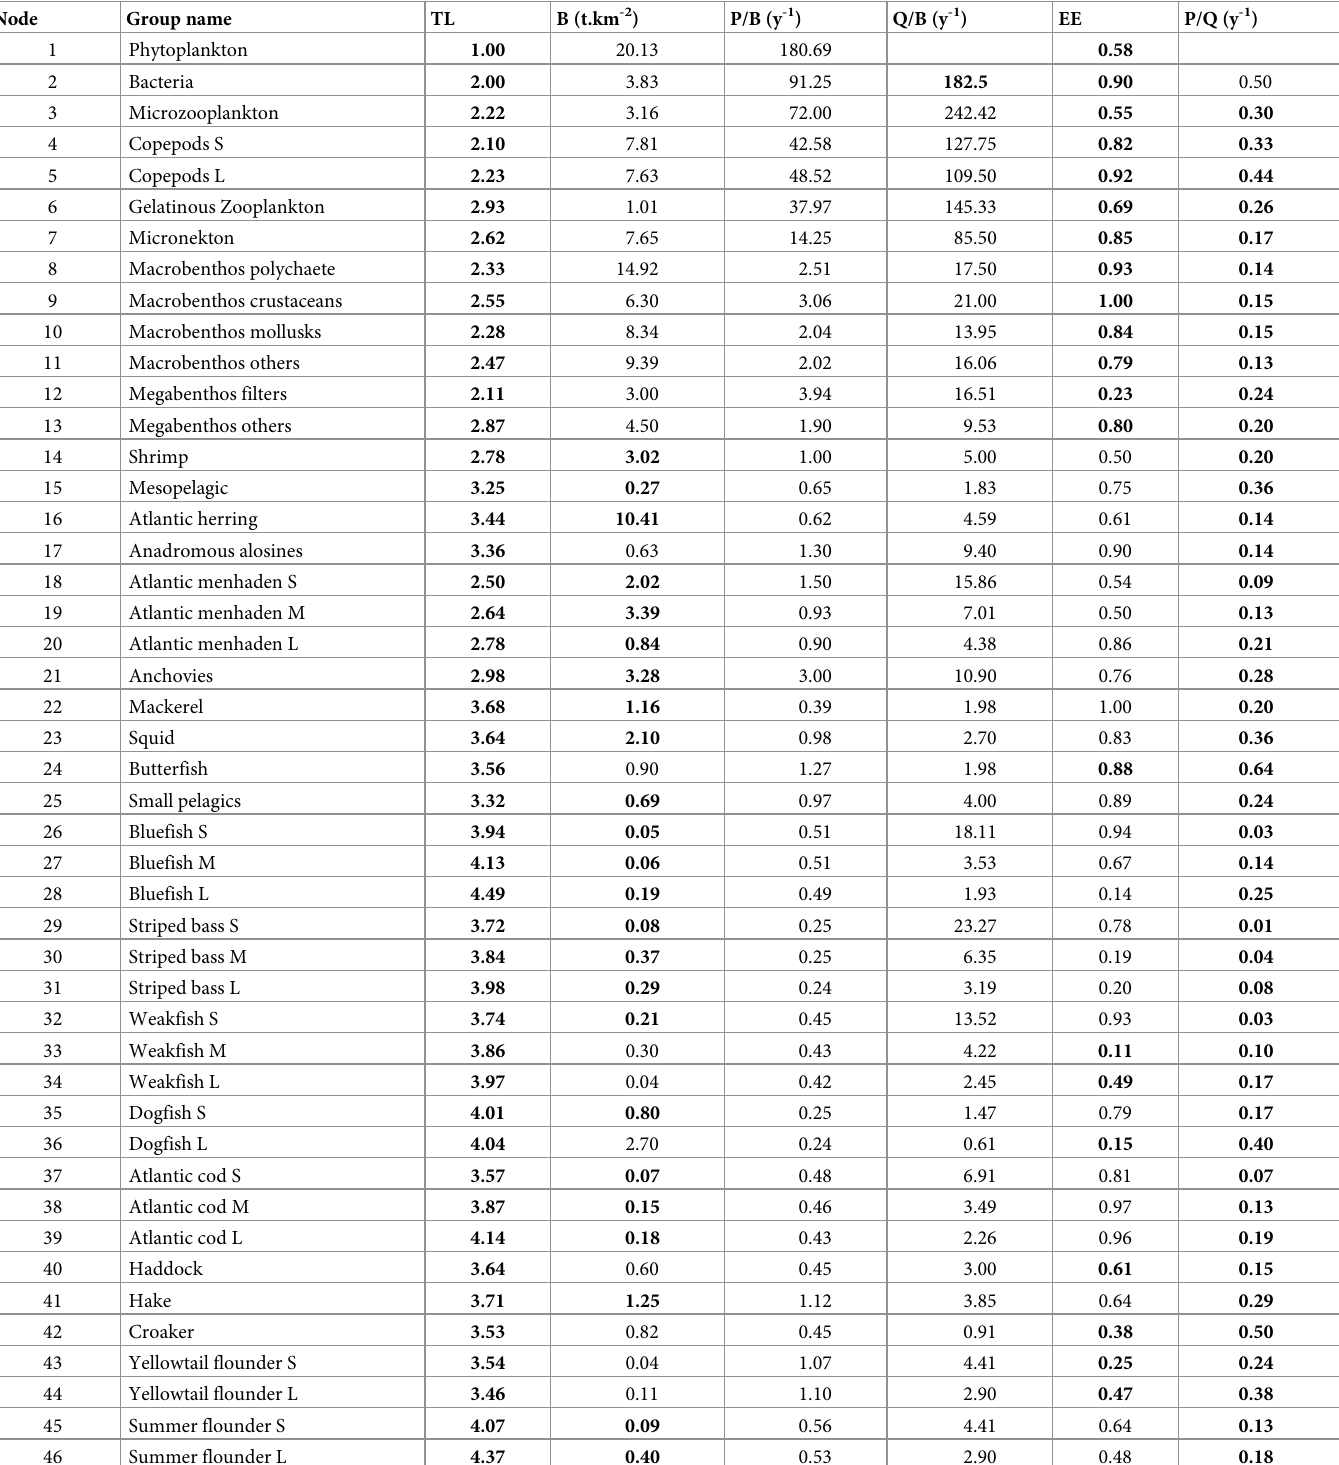
Table 2. Functional groups input parameters sources for the Restored Alosine Biomass (RAB) model for the NEUS LME. Inputs parameters are the production-bio- mass ratio (P/B), the consumption-biomass ratio (Q/B), and Ecotrophic Efficiency (EE) from CAB model. Output parameters calculated by EwE are Trophic level (TL), Biomass (B) and the consumption-production ratio (P/Q), signaled in